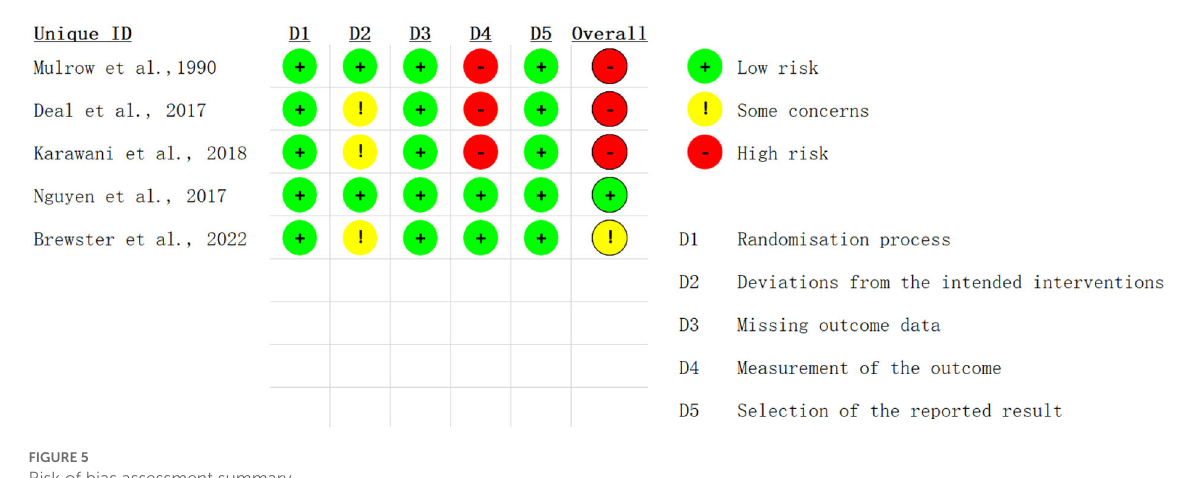
FIGURE5 Risk of bias assessment